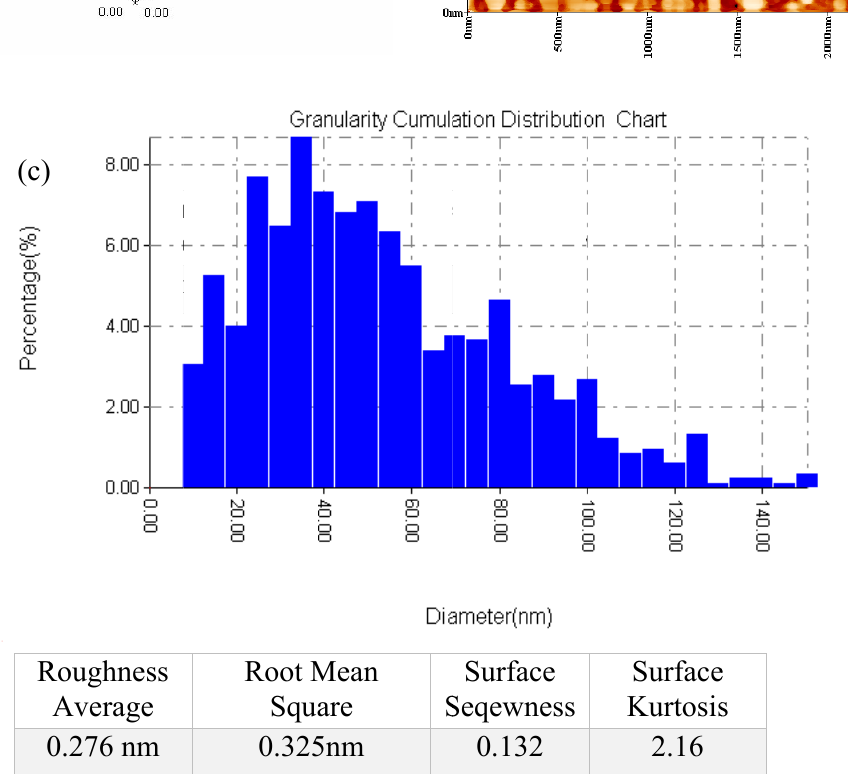
deco nan irrad 200 wav